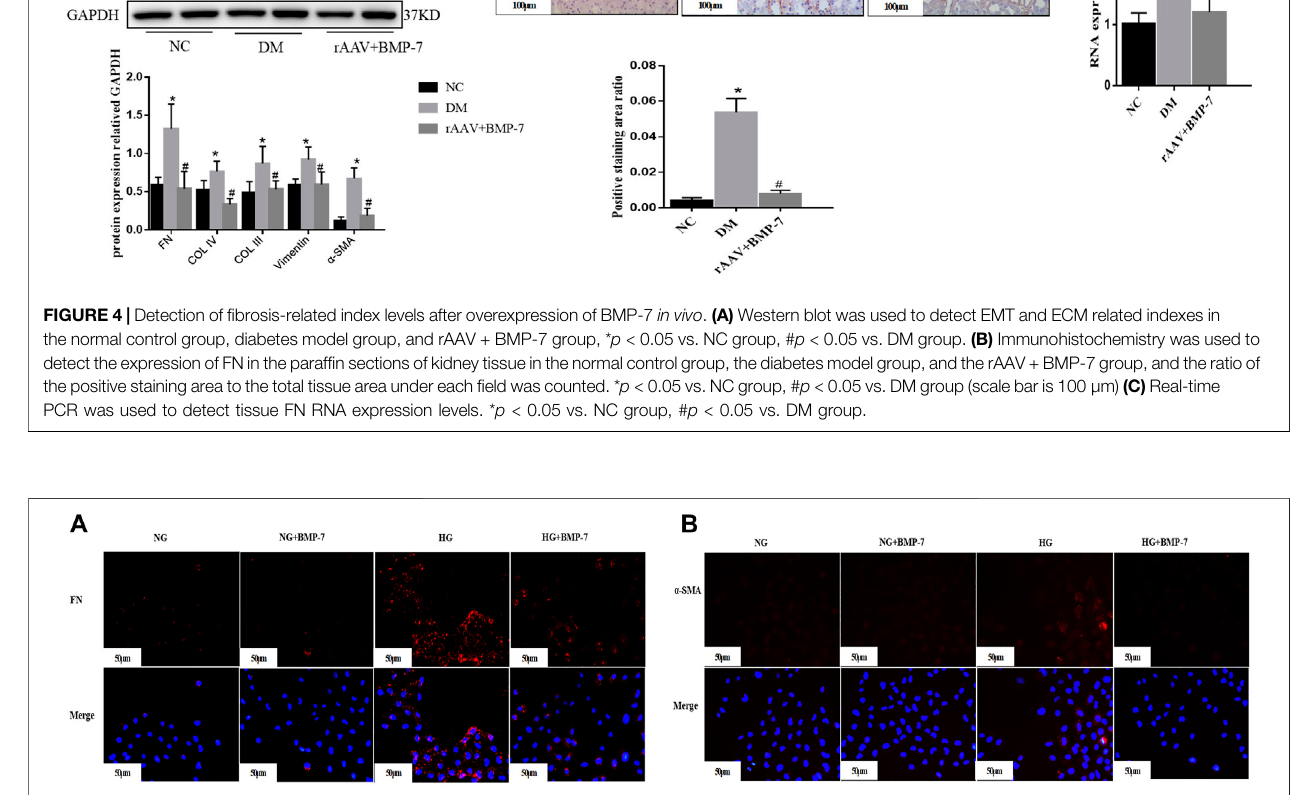
FIGURE 5 | (A) The expression of FN in cells was detected by immuno fl uorescence (scale bar is 50 μ m). (B) The expression of α -SMA in cells was detected by immuno fl uorescence (scale bar is 50 μ m).